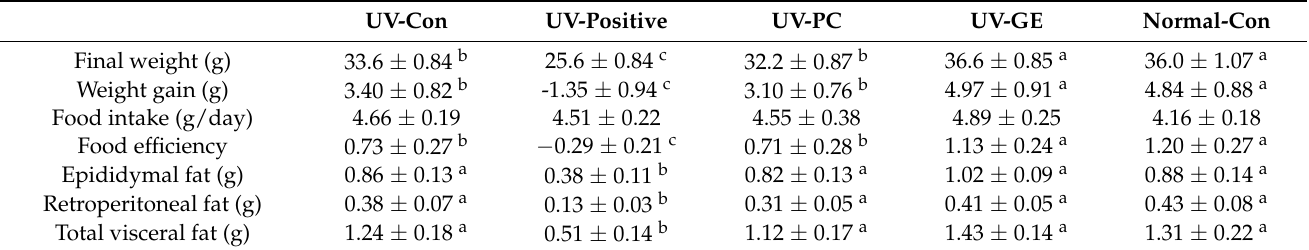
Table 1. Body composition and food intake at the end of experimental